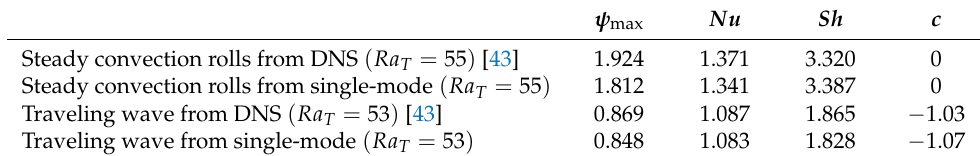
Table 2. Comparison of ψ max , Nu , Sh and c between single-mode solutions and DNS for steady convection rolls at Ra T = 55 and traveling waves at Ra T = 53. Other parameters are R ρ = 0.1, Le = 5, k x = π and k y = 0; the DNS results are computed with periodic B.C. in the horizontal with period L x = 2 π / k x = 2 (Figure 8 and p. 79 in [43]).